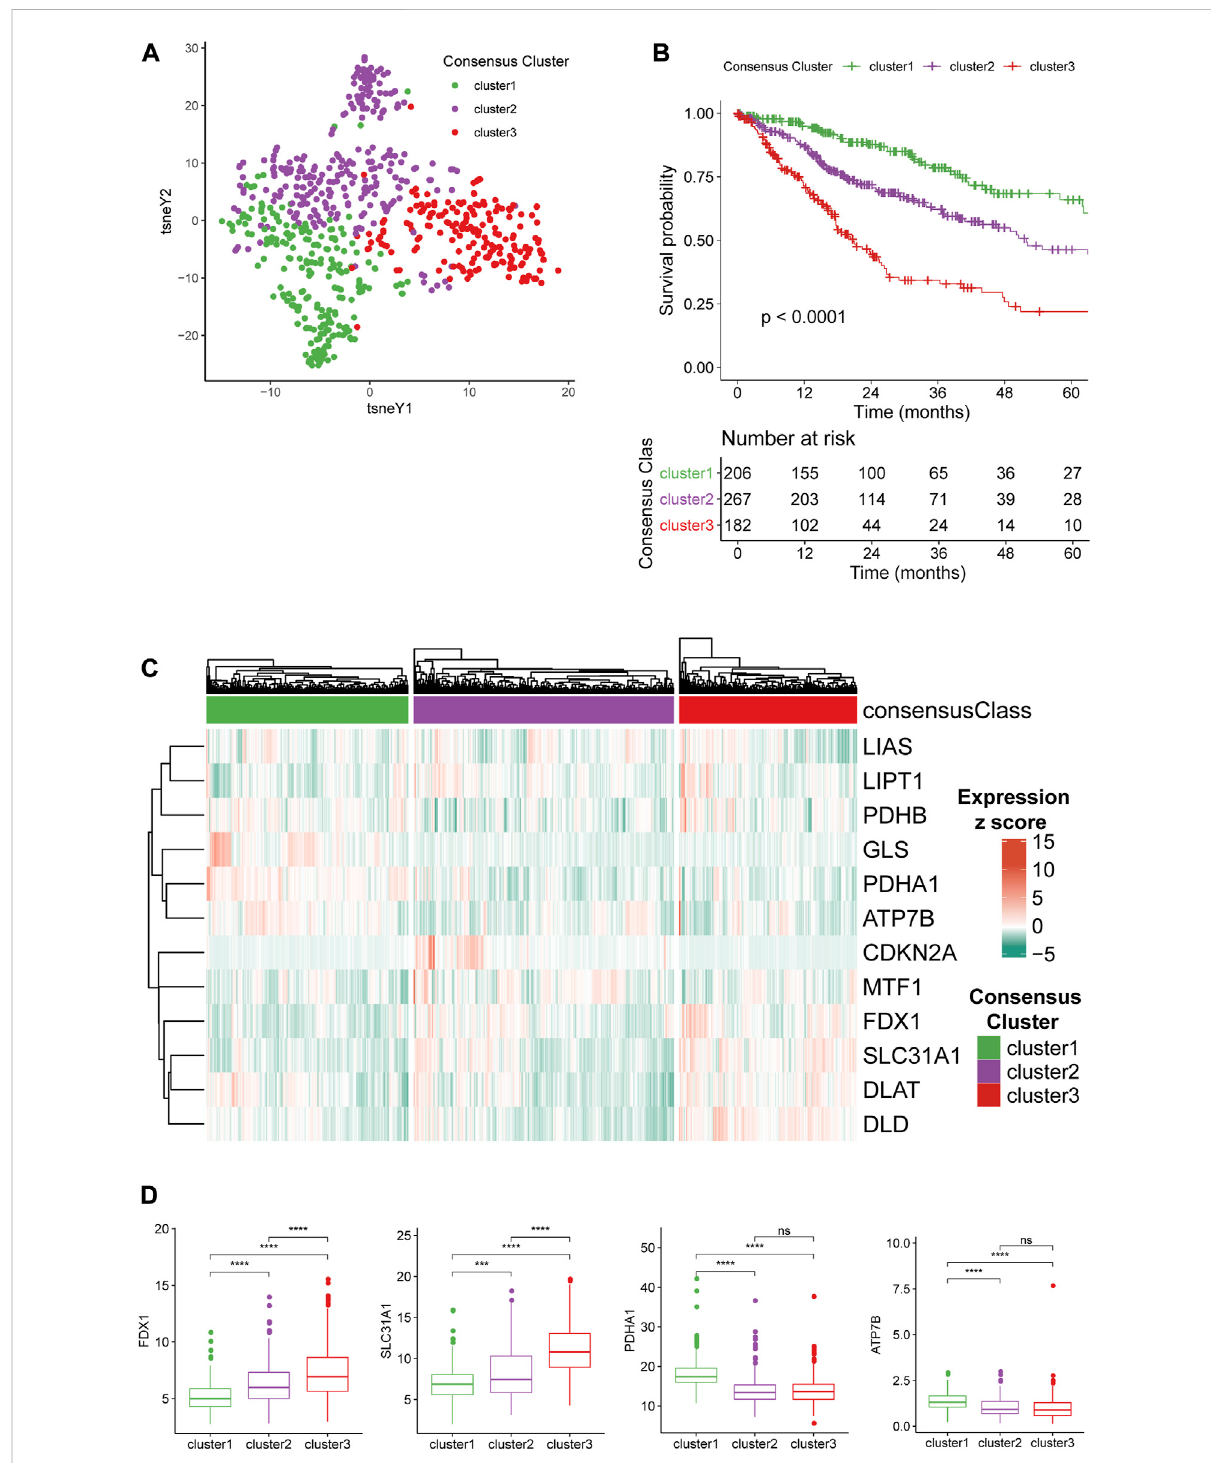
FIGURE 1 Consensus clustering of gliomas based on CRG expression. (A) CRG expression tSNE of the consensus clusters. (B) Kaplan-Meier Curve of the consensusclusters( p < 0.0001). (C) Heatmapoftheexpressionlevelof12CRGsintheconsensusclusters. (D) TheexpressionlevelofFDX1,SLC31A1, PDHA1, and ATP7B between the consensus